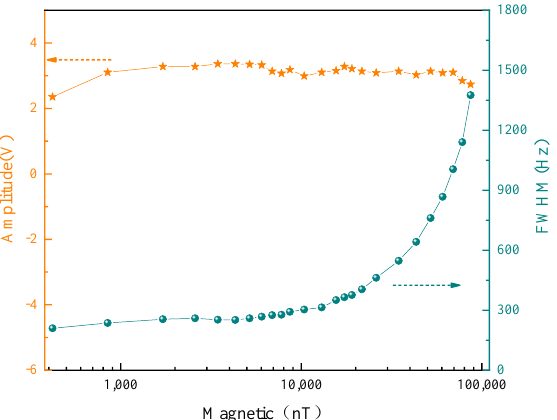
Figure 6. Dependence of FID signal amplitude and FWHM on static magnetic field.